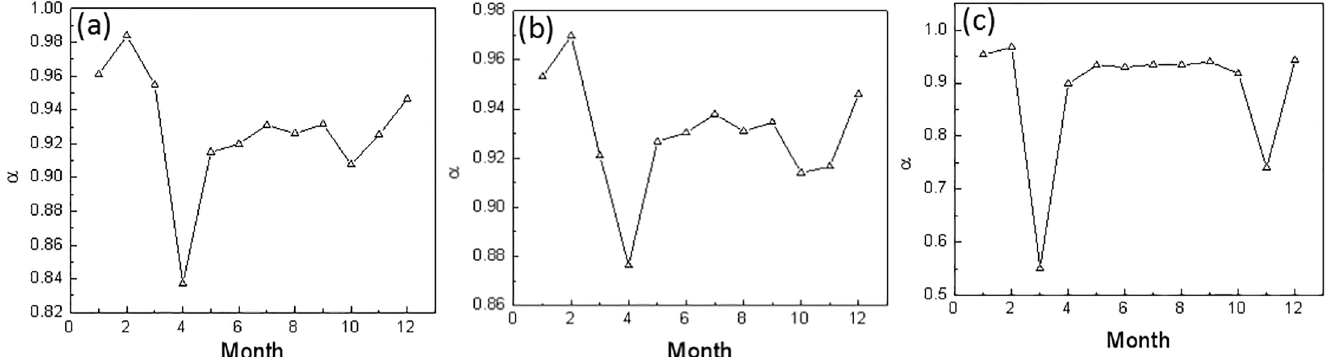
Fig 5. The scaling exponent of the monthly mean temperature from 1909–2014 at the three stations: (a) Harbin; (b) Changchun; (c) Shenyang.